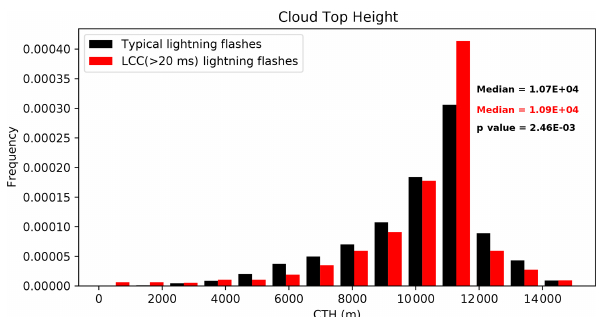
Figure 19. Frequency distribution of the CTH values reported by EUMETSAT, based on measurements of the MSG satellites, for typ- ical lightning flashes and LCC( > 20ms) lightning flashes reported by ISS-LIS over Europe between March and September in 2017–